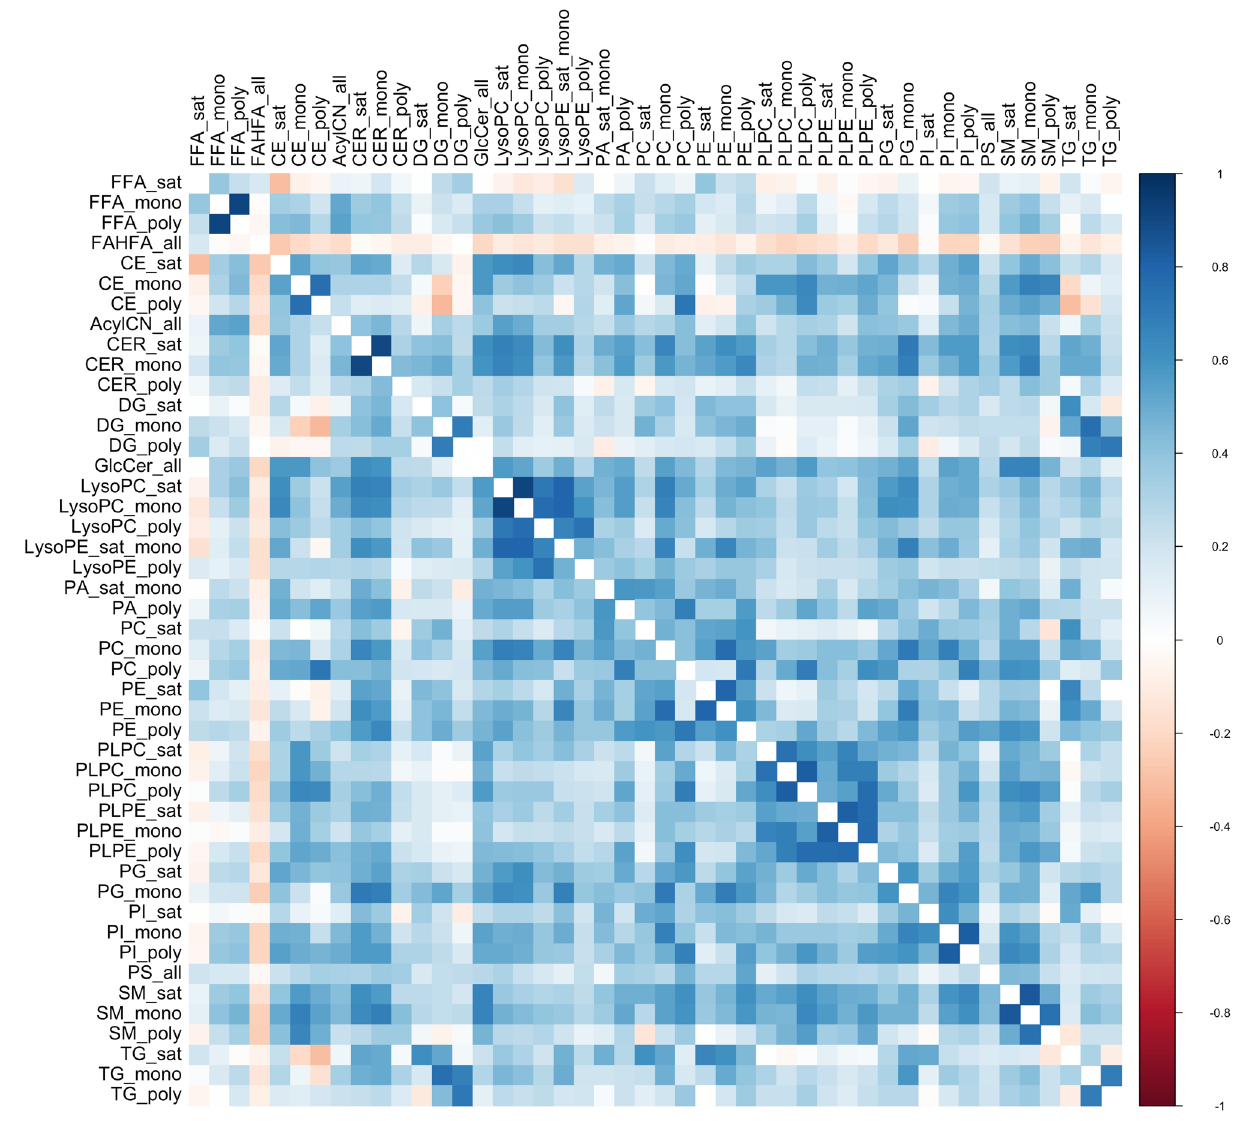
Figure 1. Correlation matrix among lipid hydrocarbon saturation